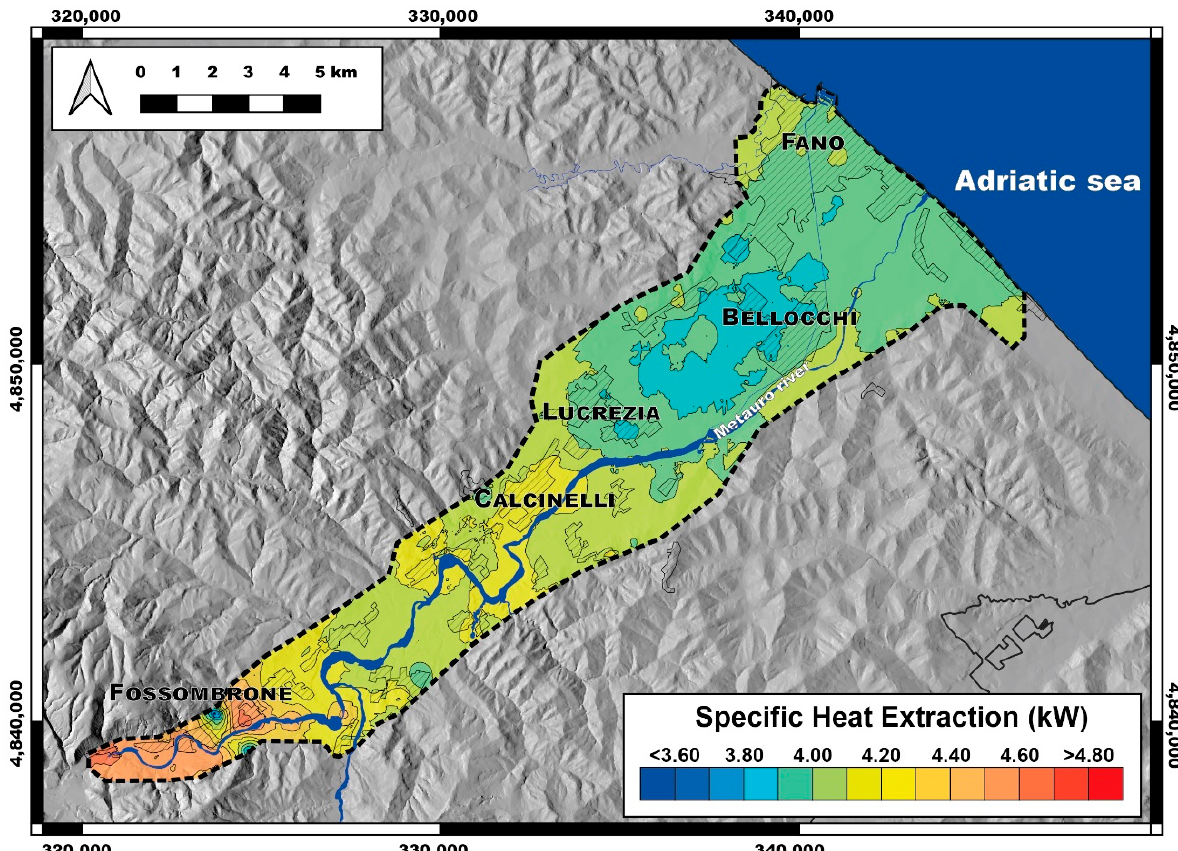
Figure 7. Map of the estimated specific heat extraction for 100 m depth boreholes .